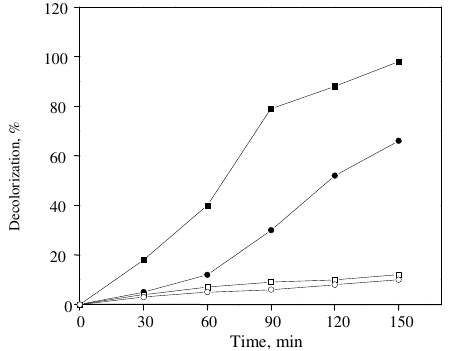
Figure 8. Comparison of the effect of UV and sunlight on the decolorisation of Vat yellow 4: C = 5 mg/L, .( ■ ) UV/TiO 0 SL/TiO , ,( □ ) UV, ( ○ ) SL 2